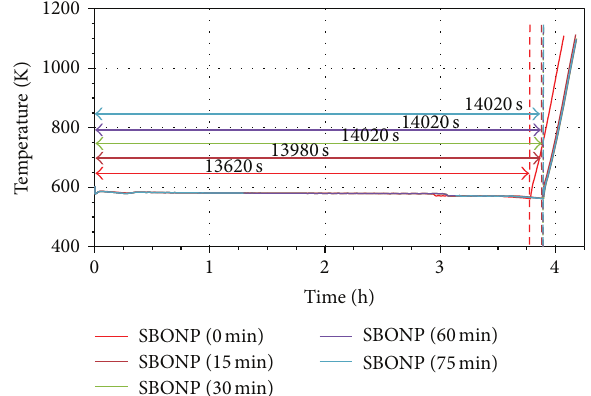
Figure 6: Average fuel cladding temperature at the top of the core, SBONP case scenarios.